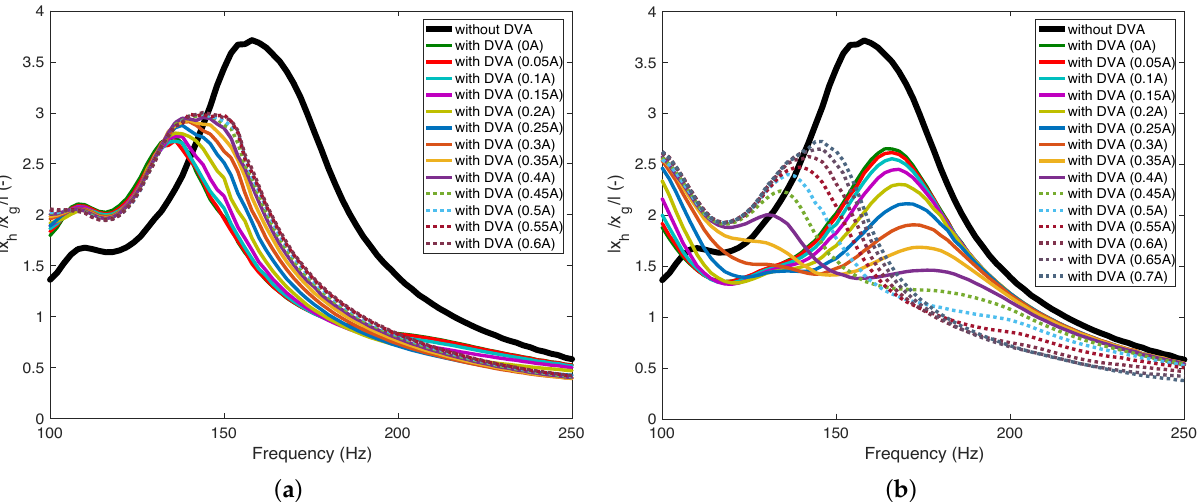
Figure 13. Effect of the MRE pad thicknesses on the vibration isolation performances of the MRE- DVAs: ( a ) 1 mm thickness and ( b ) 2 mm